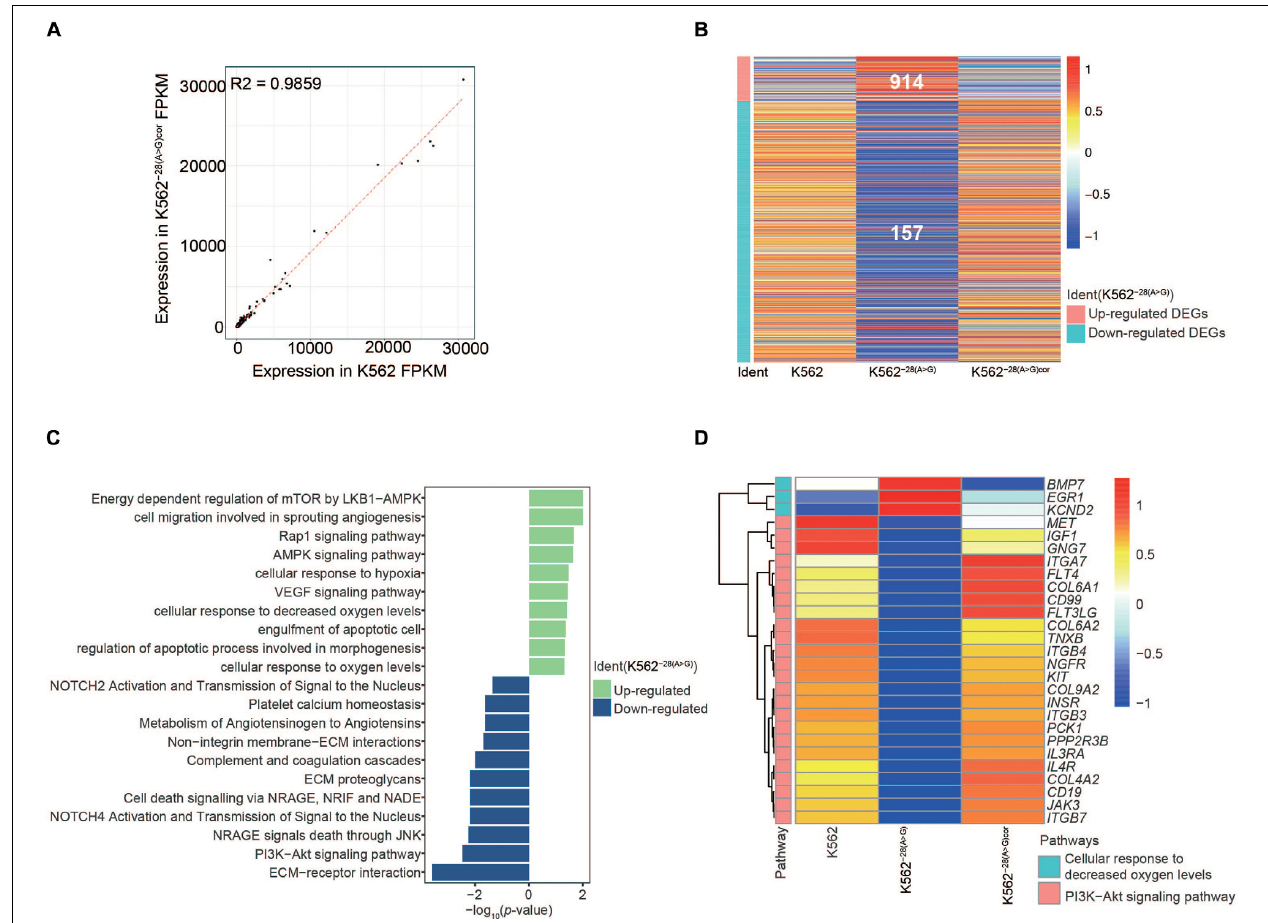
FIGURE 5 | Genes and key pathways are reversed in mutation-corrected K562 − 28 ( A > G ) cor cell line. (A) The correlation between K562 and K562 − 28 ( A > G ) cor cell lines. (B) The upregulated and downregulated DEGs in K562, K562 − 28 ( A > G ) , and K562 − 28 ( A > G ) cor . (C) Differentially regulated signaling pathways